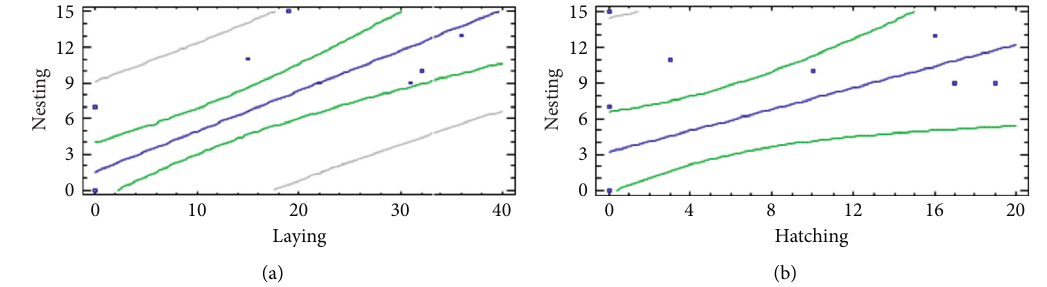
Figure 5: Relationship between nesting dates, laying, and hatching initiation.